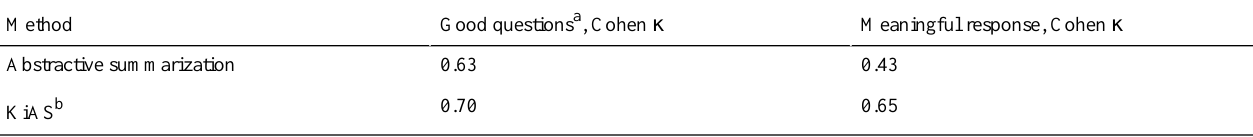
Table 5. Interannotator agreement (Cohen κ ) calculated over summaries evaluated by 4 mental health